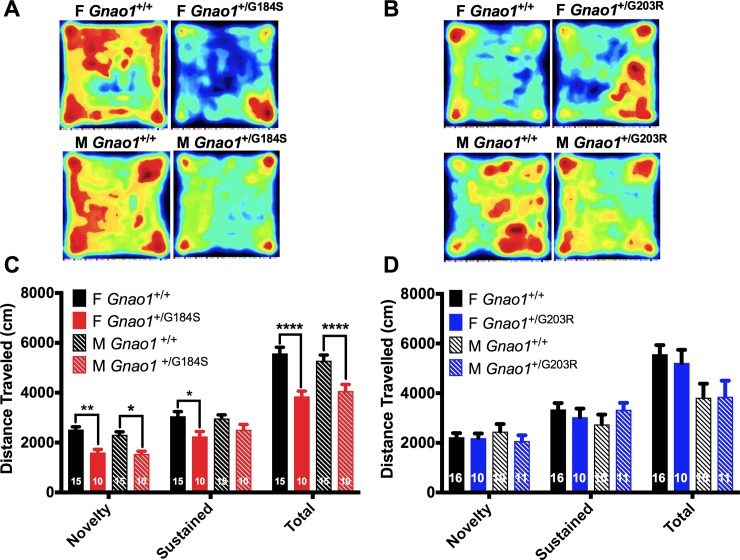
G184S mutant mice showed reduced activities in open field test but G203R mutants don’t.(A&C) Female and male Gnao1+/G184S mice showed decreased activity in the open field test. A total of 30 min activity was recorded which was divided into a Novelty (0–10 min) and a Sustained (10–30 min) period. (A) Representative heat map of overall activity comparing Gnao1+/+ and Gnao1+/G184S mice of both sexes. (C) Quantitatively, both male and female Gnao1+/G184S travelled less in the open field arena (2-way ANOVA; ****p< 0.0001, **p<0.01, *p<0.05). (B & D) Neither male nor female Gnao1+/G203R mice showed abnormalities in the open field arena. (B) Sample heat map tracing of female and male mouse movement in open field. (D) Quantification showed no difference between Gnao1+/+ and Gnao1+/G203R mice in distance traveled (cm) in the open field arena (2-way ANOVA; n.s.). Data are shown as mean ± SEM. Numbers of animals are indicated on bars.